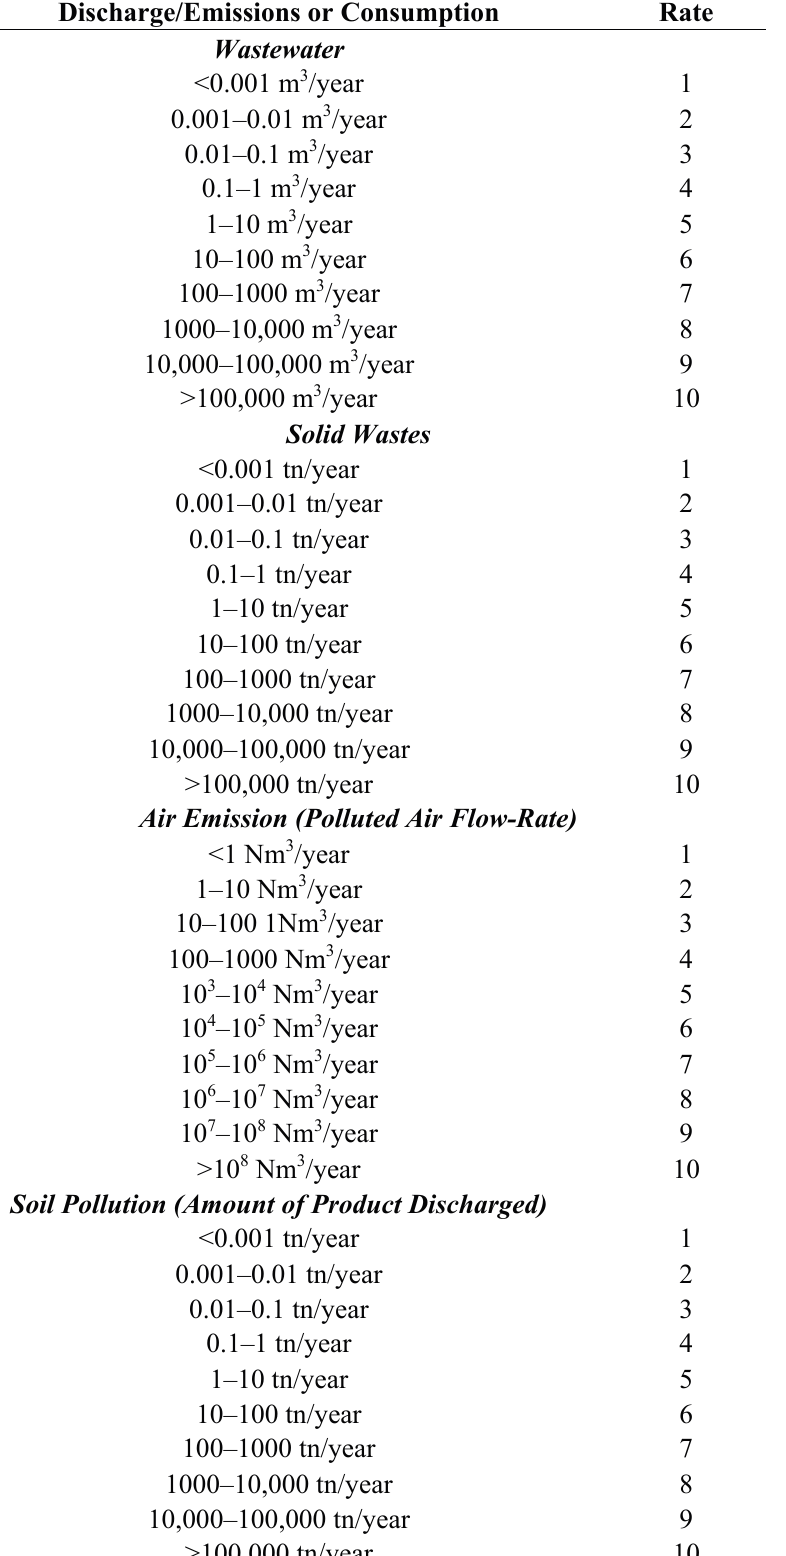
Table 4. Parameter C (Amount): Numerical values for Parameter C, assigned by the amount of product or energy consumption